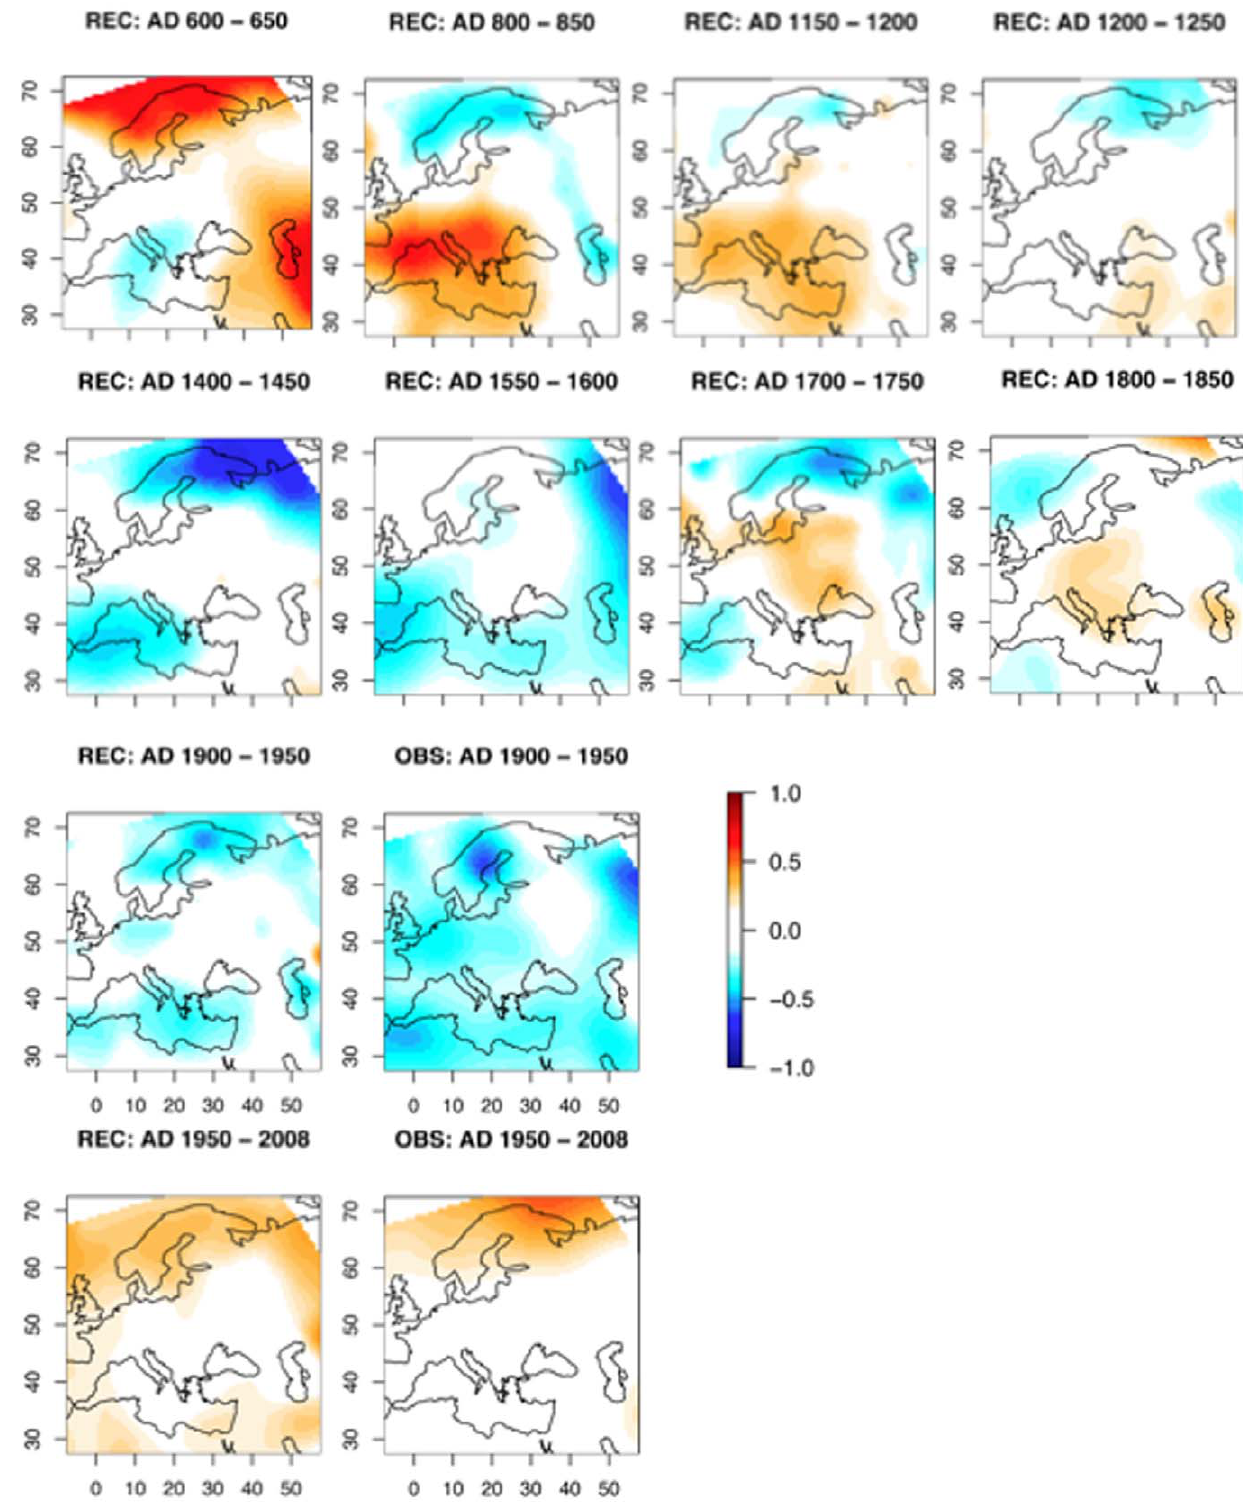
Figure 9. Map of April to September temperature anomalies averaged on selected 50-years periods. REC = reconstructions, OBS = observations.